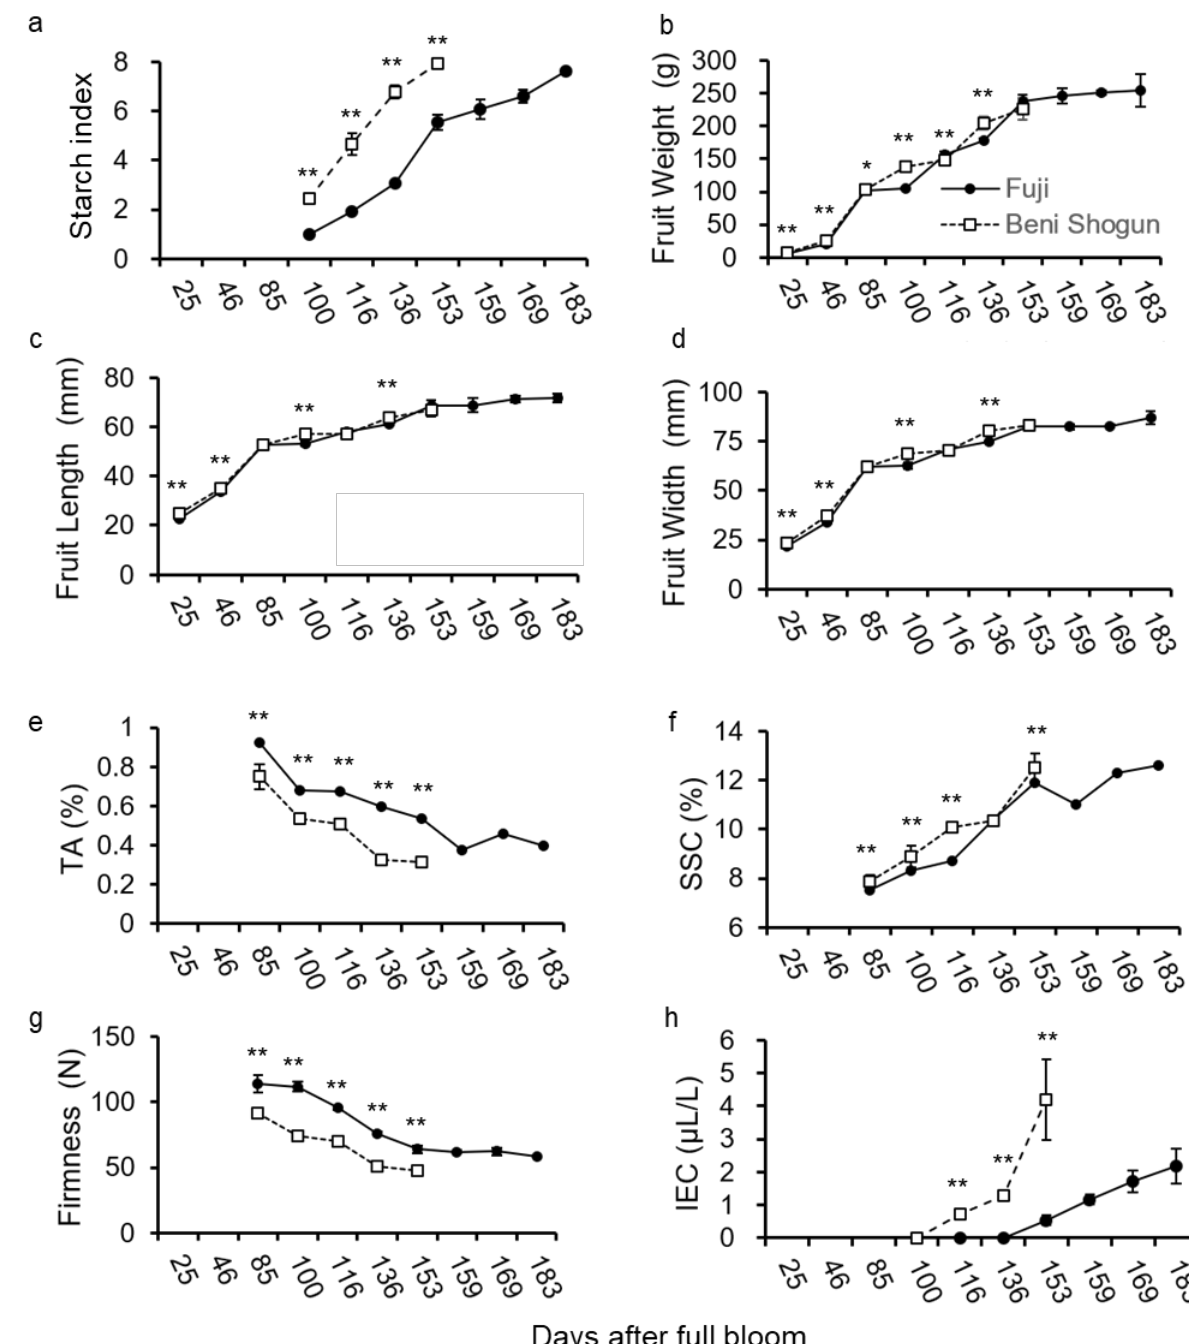
Figure 2. Fruit quality changes in ‘Fuji’ and ‘Beni Shogun’ during developmental stages. Starch–iodine index ( a ), fruit weight ( b ), length ( c ), width ( d ), titratable acidity (TA) ( e ), soluble solids content (SSC) ( f ), firmness ( g ), and internal ethylene concentration (IEC) ( h ) were measured until maturity. The starch–iodine index values are based on the Cornell index chart. Error bars indicate the ± SE ( n = 9), where the IEC and starch–iodine index were n = 15. Single stars (*) indicate statistical significance at p < 0.05, while double stars (**) indicate significance at p < 0.01. ‘Beni Shogun’ fruits reached the starch index of 8 on 22 September, while ‘Fuji’ fruits reached the Cornell starch index of 8 on 22 October, which was 183 DAFB. The fruit weight, length, and width of both ‘Fuji’ and ‘Beni Shogun’ grew similarly until 153 DAFB.